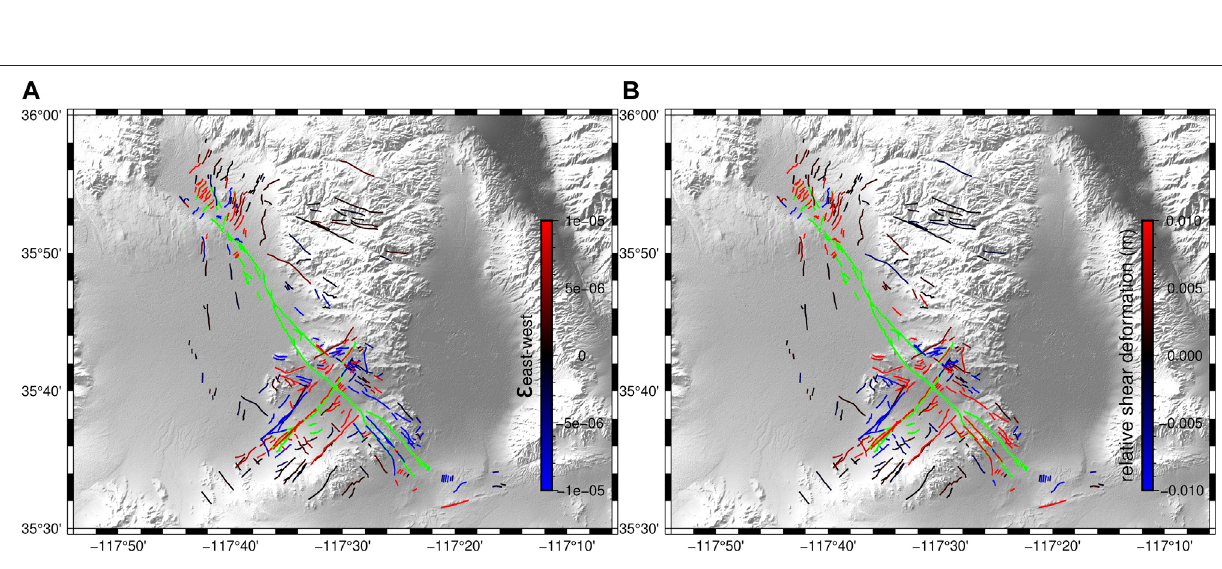
Frontiers in Earth Science |